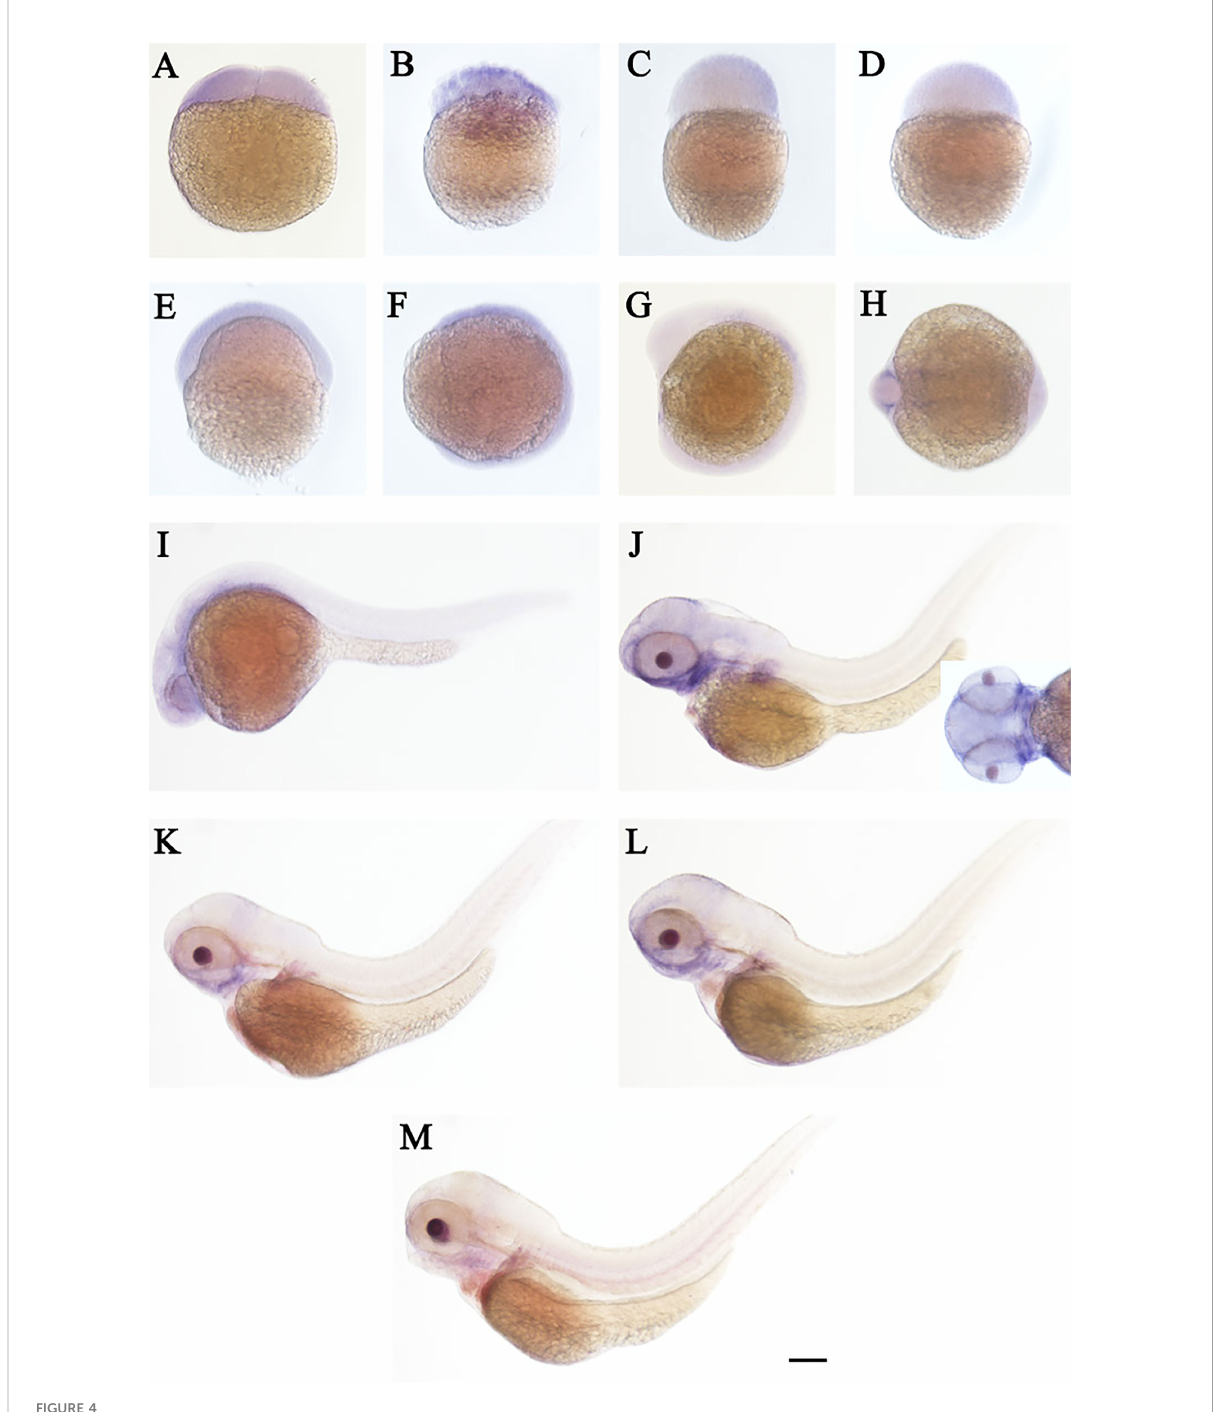
FIGURE 4 WISH of cd248a in zebra fi sh early embryos. Stages of embryonic development: (A) 2-cell; (B) 32-cell; (C) 512-cell; (D) sphere; (E) shield; (F) bud; (G, H) 10 somites; (I) 24 hpf; (J) 48 hpf; (K) 72hpf; (L) 96 hpf; (M) 120 hpf. hpf, hours post-fertilization. Scale bar, 100 m